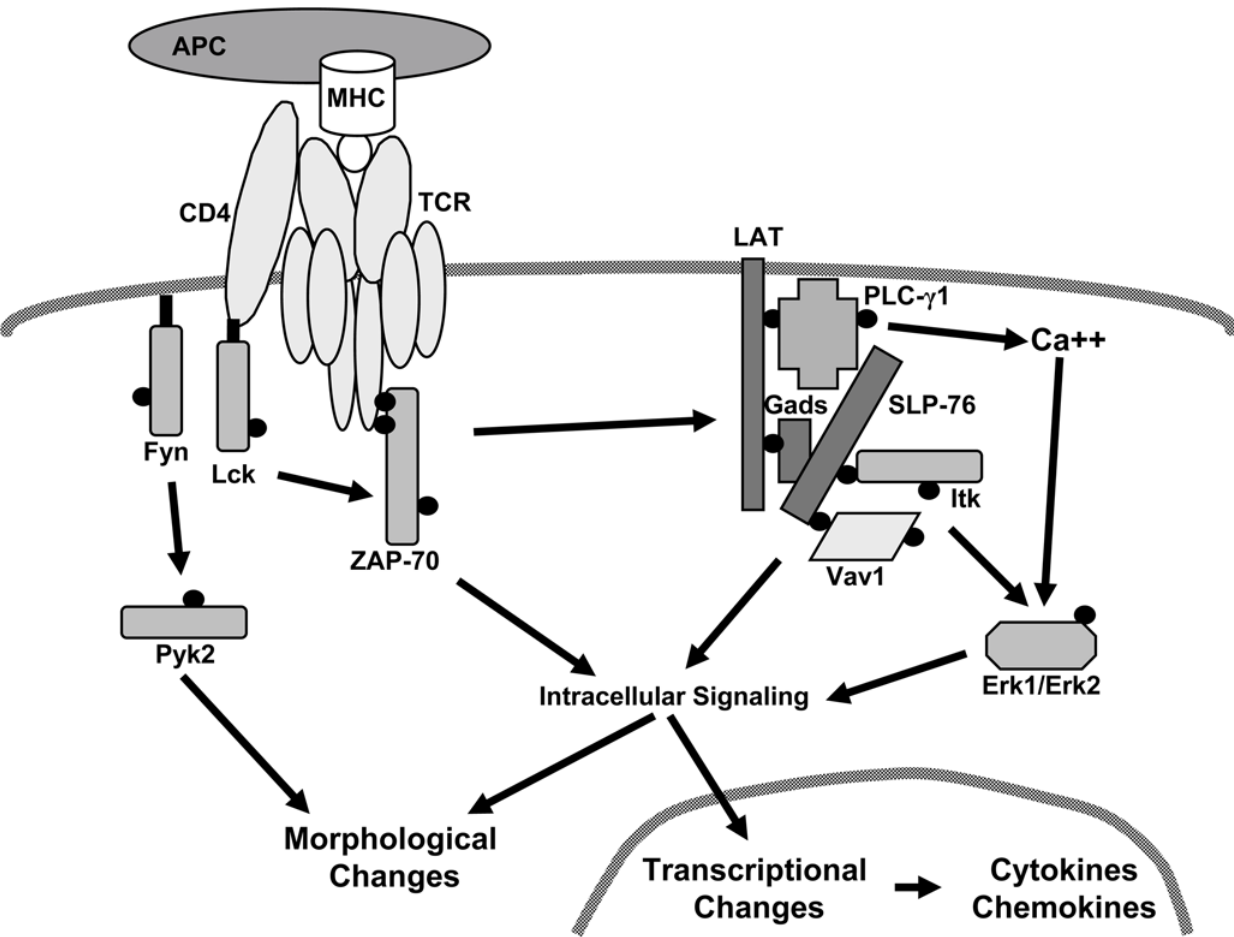
Figure 1. Current model of proximal signaling pathways downstream of TCR activation. TCR activation leads to the induction of numerous tyrosine kinases and adaptor proteins. The activation of these signaling molecules leads to morphological changes and alterations in transcription that are vital for T cell activation and function. Proteins that are tyrosine phosphorylated upon TCR stimulation are identified with small black circles.